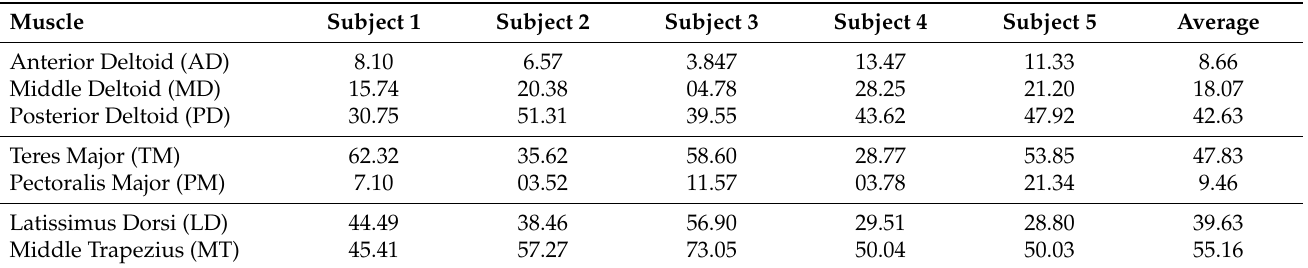
Table 3. Muscle activation (% of MVIC) of the seven shoulder muscles among five subjects from preliminary study.